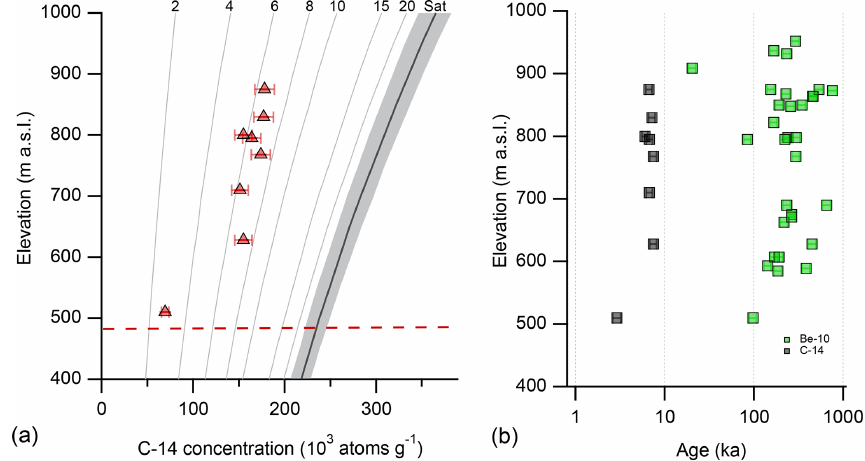
Figure 6. (a) Elevation versus in situ 14 C concentration of samples collected from the Lassiter Coast. All samples are bedrock. (b) In situ 14 C exposure ages with 10 Be ages of Johnson et al.